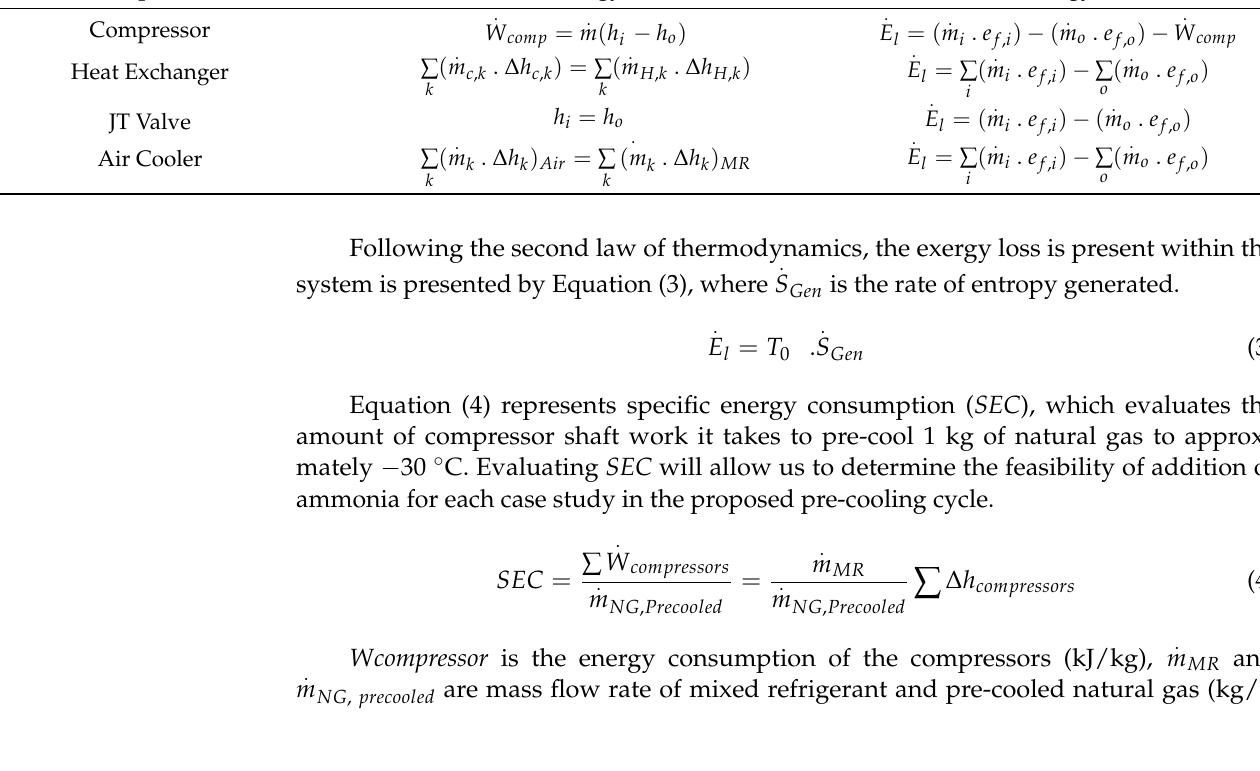
Table 4. Energy and exergy relations used for major equipment in the proposed pre-cooling cycle.